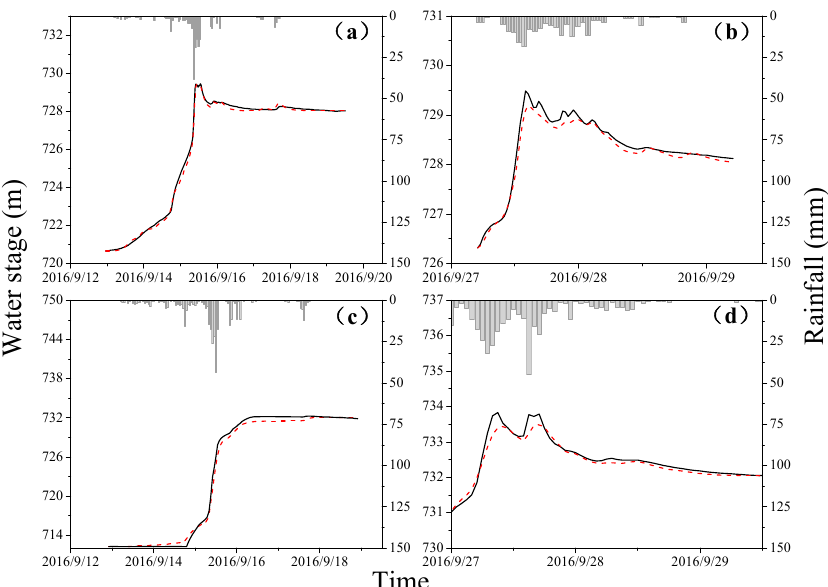
Figure 7. Verification results of four flash flood events using reservoir water stage data: ( a ) Verification result of Longxi 20160915 event; ( b ) Verification result of Longxi 20160928 event; ( c ) Verification result of Qinglan 20160915 event; ( d ) Verification result of Qinglan 20160928 event. Table 7. Model verification performance using river water stage data.